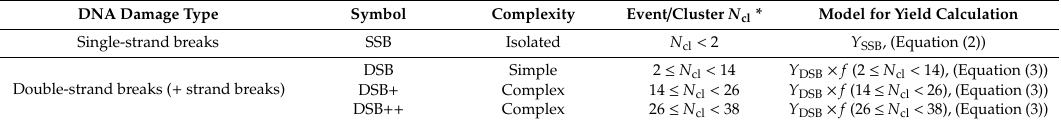
Table 2. Classification of complex DSB coupled with strand breaks in the present model.